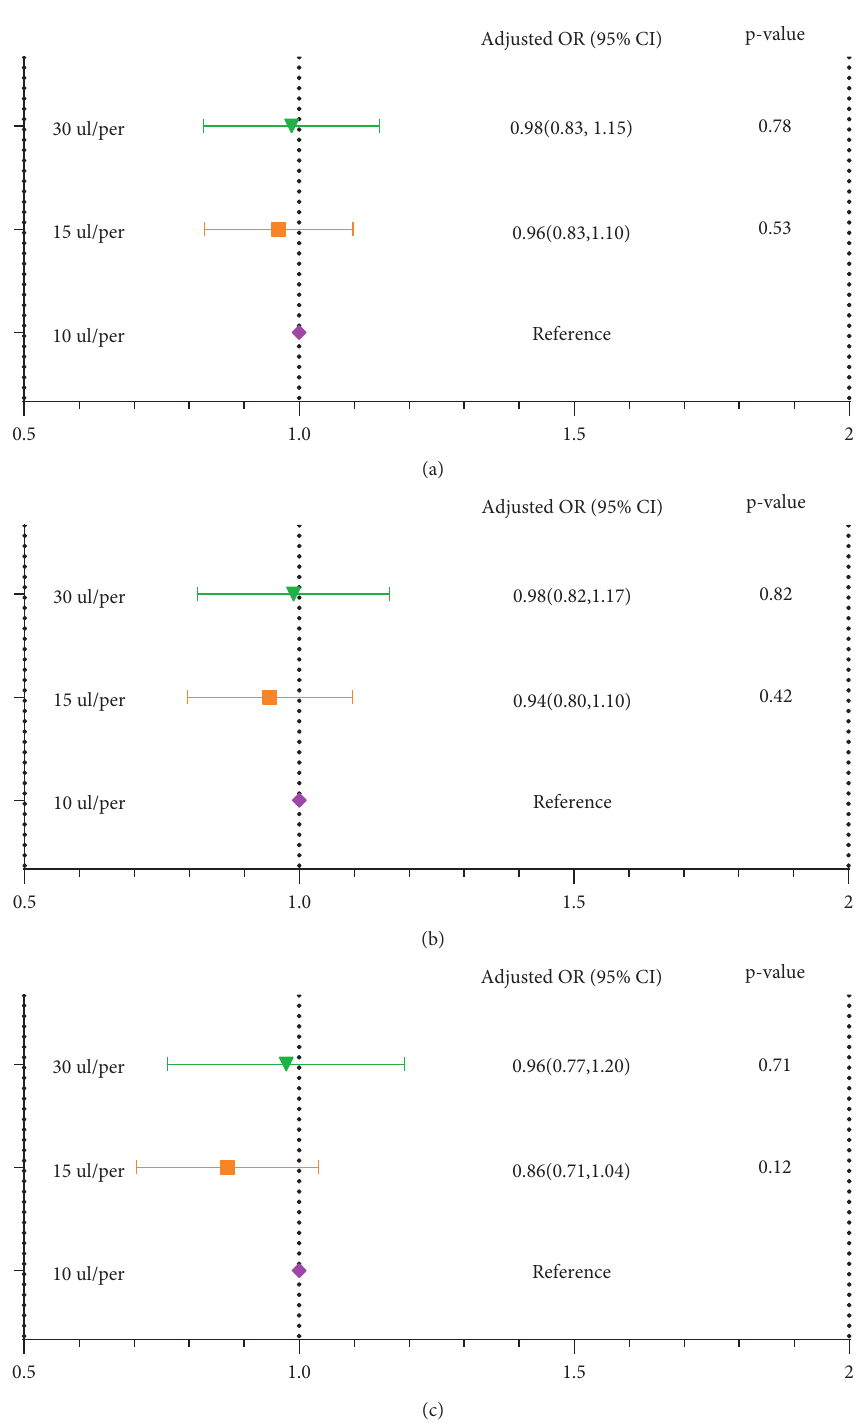
Figure 4: Relationship between embryo density and quality of day-3 embryos in different models. The analysis was performed by GEE (generalized estimate equation) model, subject ID � patient unique medical record number (independence). (a) Crude model: no factor was adjusted; (b) Model I: the number of retrieved oocytes, incubator COOK8, culture medium, and primary infertility were adjusted; (c) Model II: maternal age, paternal age, maternal BMI, type of infertility, type of insemination, COS protocol, AMH, the number of retrieved oocytes, length of stimulation, antral follicles, incubator, and culture medium were